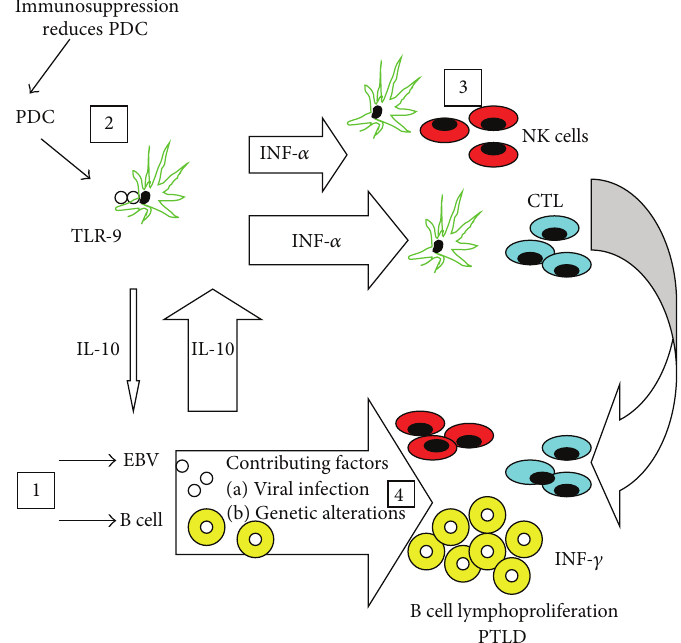
Figure 1: This proposed model of pathogenesis shows EBV infection of B cells (1), concurrent immunosuppression of plasmacytoid dendritic cells, PDCs, (2), net increase in IL-10, release of 𝛼 -interferon and 𝛾 -interferon, and stimulation of cytotoxic T lymphocytes and NK cells (3), and B cell lymphoproliferation (4). From